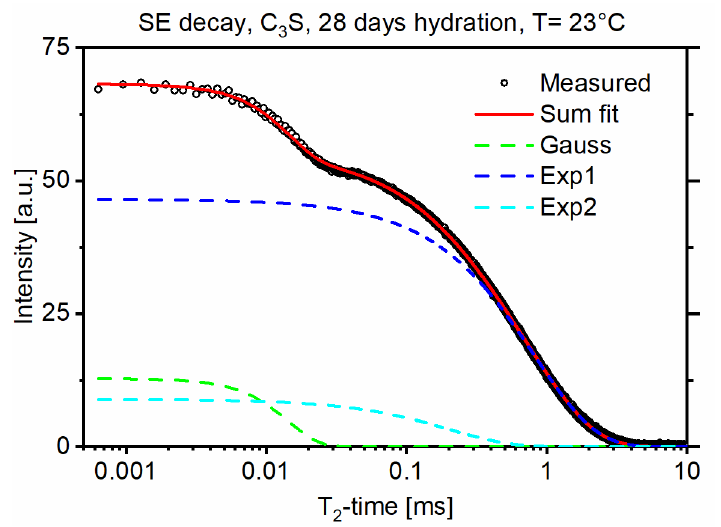
Figure 1. Solid-echo decay of a 28d hydrated C 3 S sample (black circles) with the Gaussian and exponential decay fits.